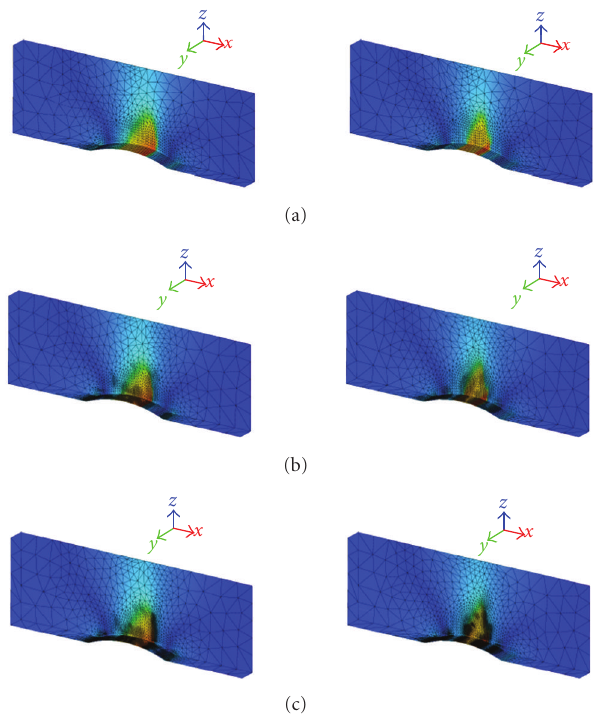
Figure 20: Adaptation/flow steps with (left) and without (right) projection—(a) only flow calculation step 4, (b) adapt fourth-flow 5, and (c) adapt fifth-flow 6. Solution field is C p